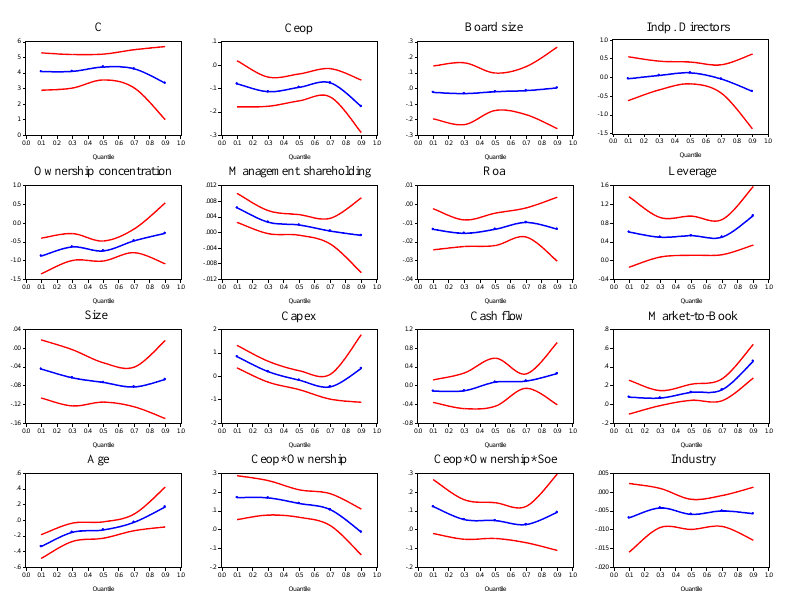
Figure 1. coefficient change of the parameters related to model1 in various quintiles.